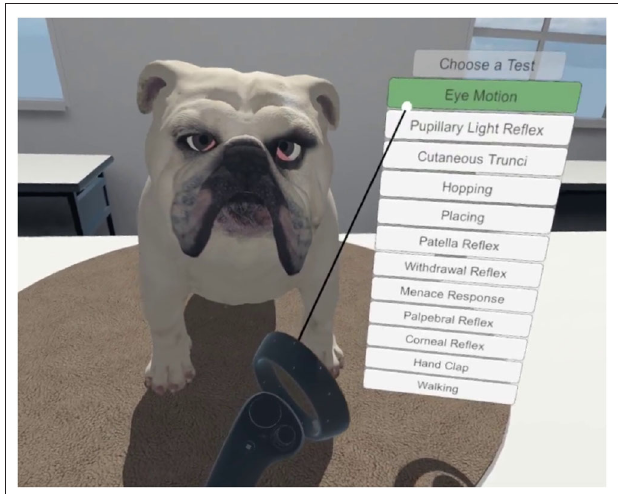
FIGURE 2 | Main menu showing all twelve tests